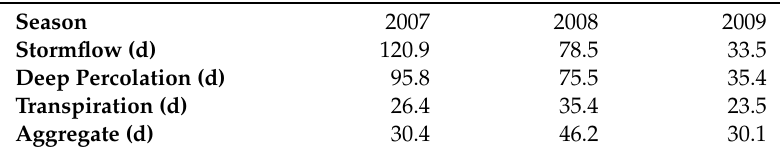
Table 5. Median travel